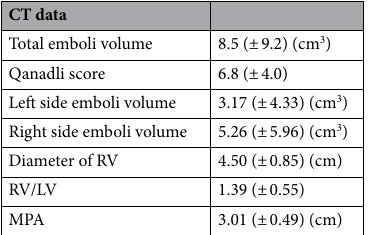
Table 2. CT assessments of pulmonary emboli. RV right ventricle, LV left ventricle, MPA diameter of main pulmonary artery.